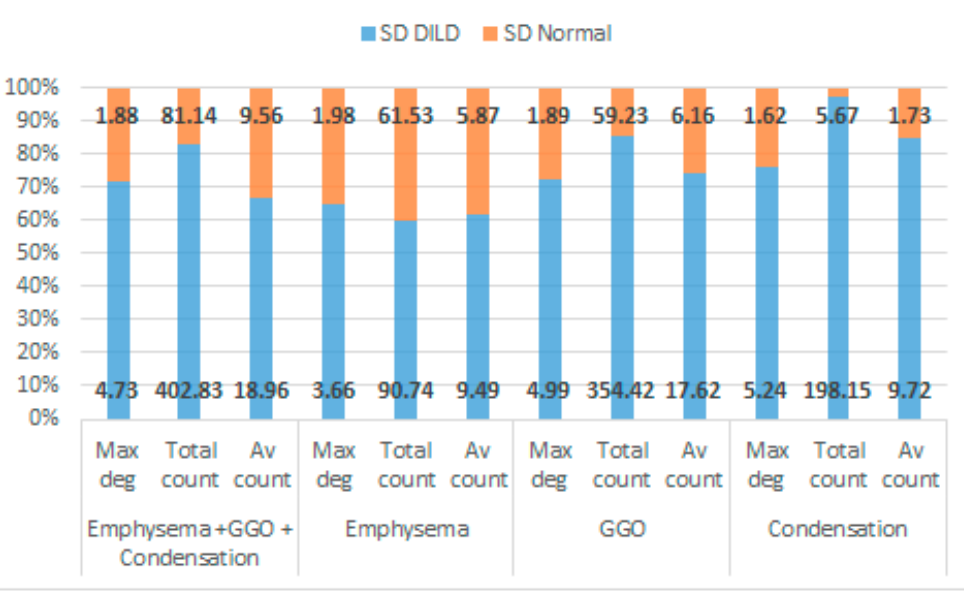
Figure 11. Relative percentage of standard deviation for DILD vs. normal lungs on all the pathological HU bands, taking into account maximum degree, total count, and average degree. Absolute values are also given for each data point.